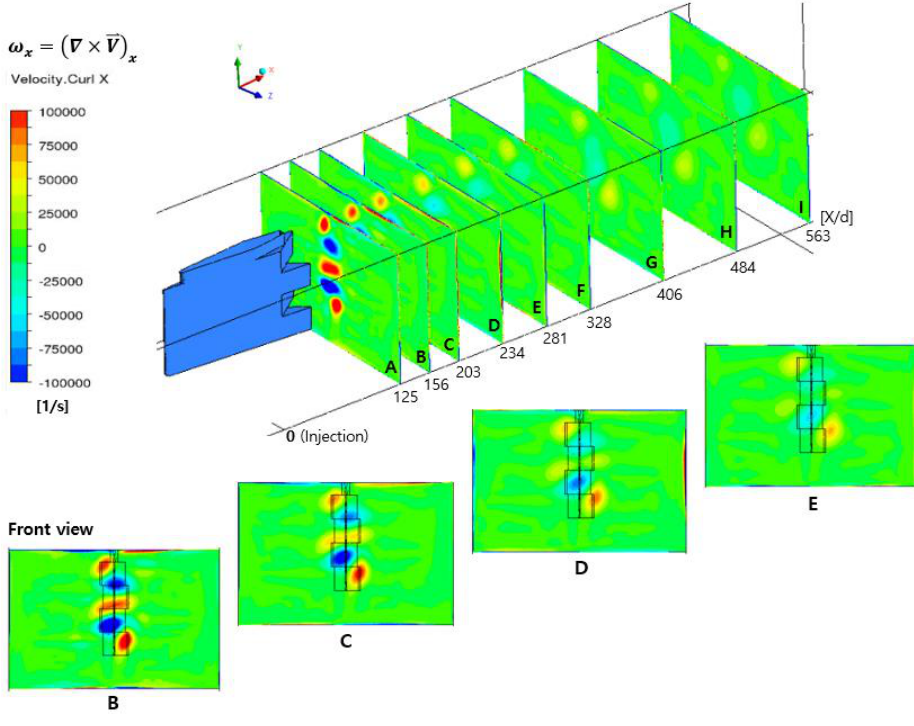
Figure 6. Streamwise vortex contours at various locations downstream of the pylon for an air tem- perature of 523 K.